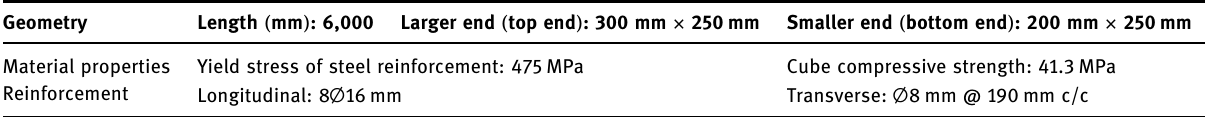
Table 2: Geometry and material properties of the column